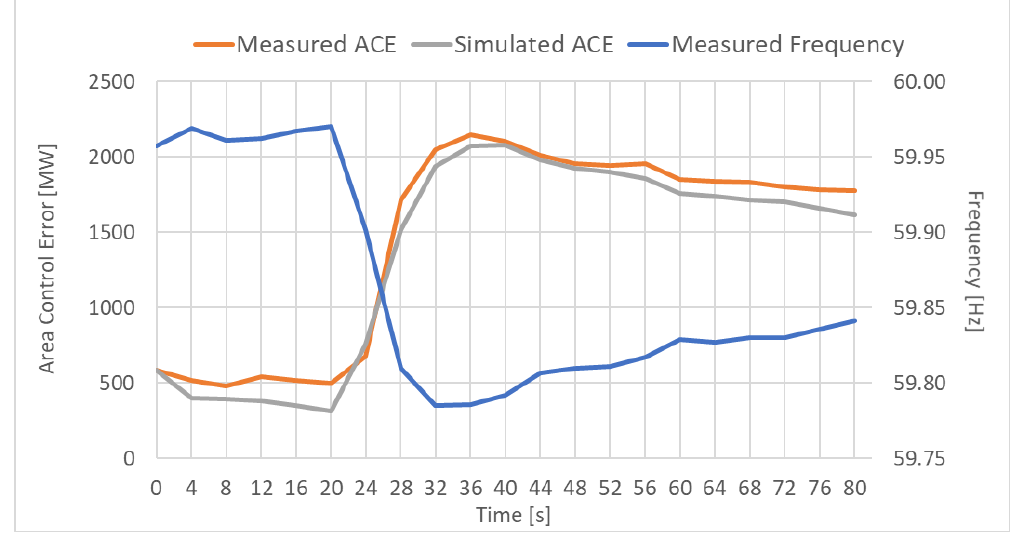
Figure 16. Comparison of the measured and the simulated ACE.